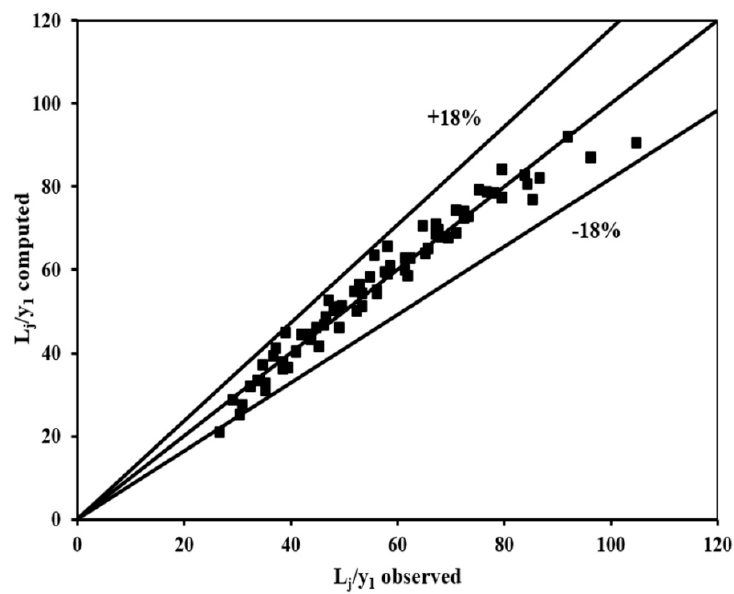
Figure 12. Comparison between the observed values of L j / y 1 in this research and those computed by Equation (25). Table 3. Comparison of variations percentage of the hydraulic jump length to the classical